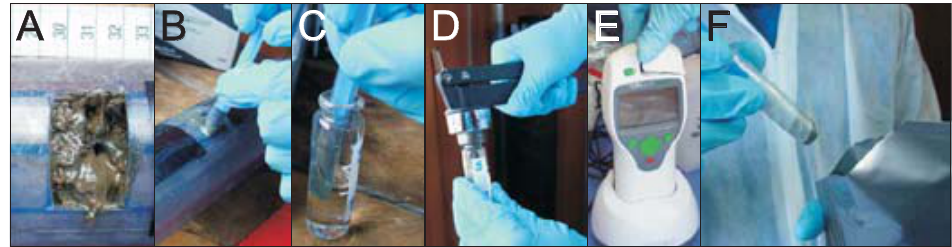
Figure 3. [A] Window cut for sampling; [B-D] sampling for methane headspace determinations; [E] preparation of the sample for in situ ATP measurements: sample is mixed with deionized water prior to centrifugation, then tested with the Uni-Lite ® NG water tester (shown); and [F] storage of the remaining sediment for cell culture. Refer to text for details.